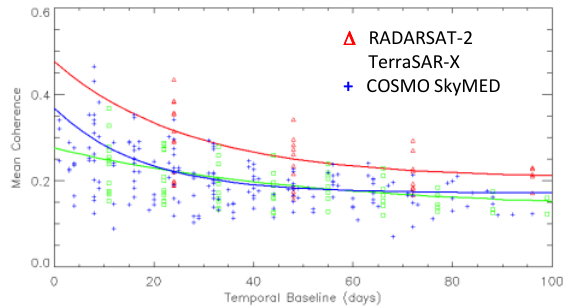
Figure 4. Sensor comparison of temporal decorrelation curves for non-rock areas. Solid curves correspond to coherence model fit to the estimates.